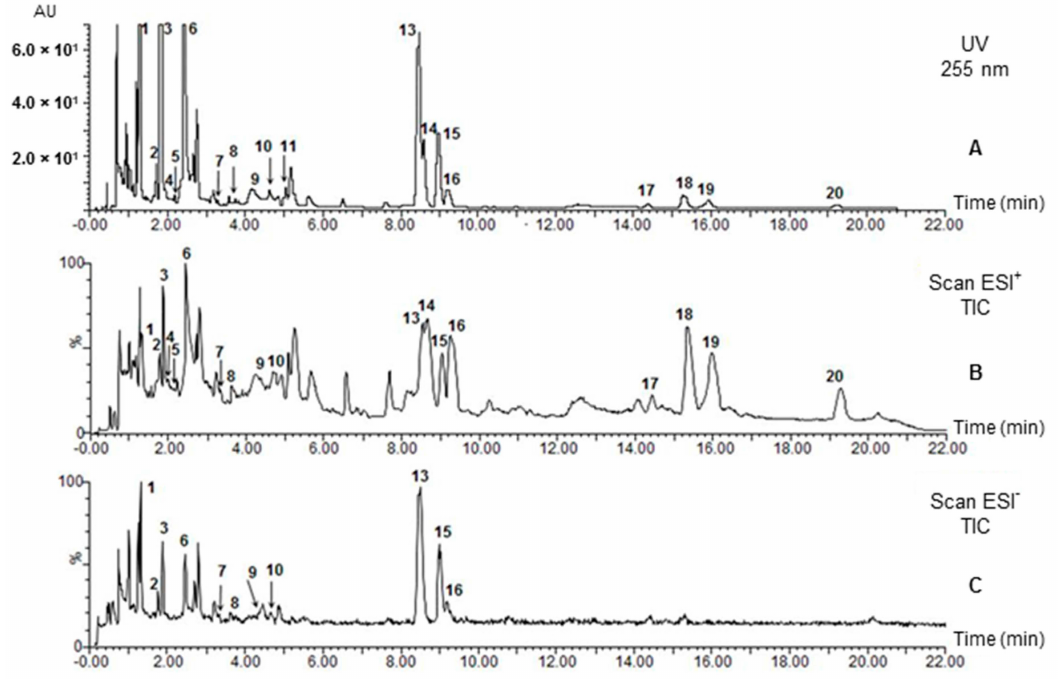
Figure 1. UPLC-UV chromatogram ( A ) and MS-ESI + ( B ) and -ESI ´ ( C ) iongrams of R. stricta alkaloids. Data for vincadifformine ( 12 ) is presented in Figure